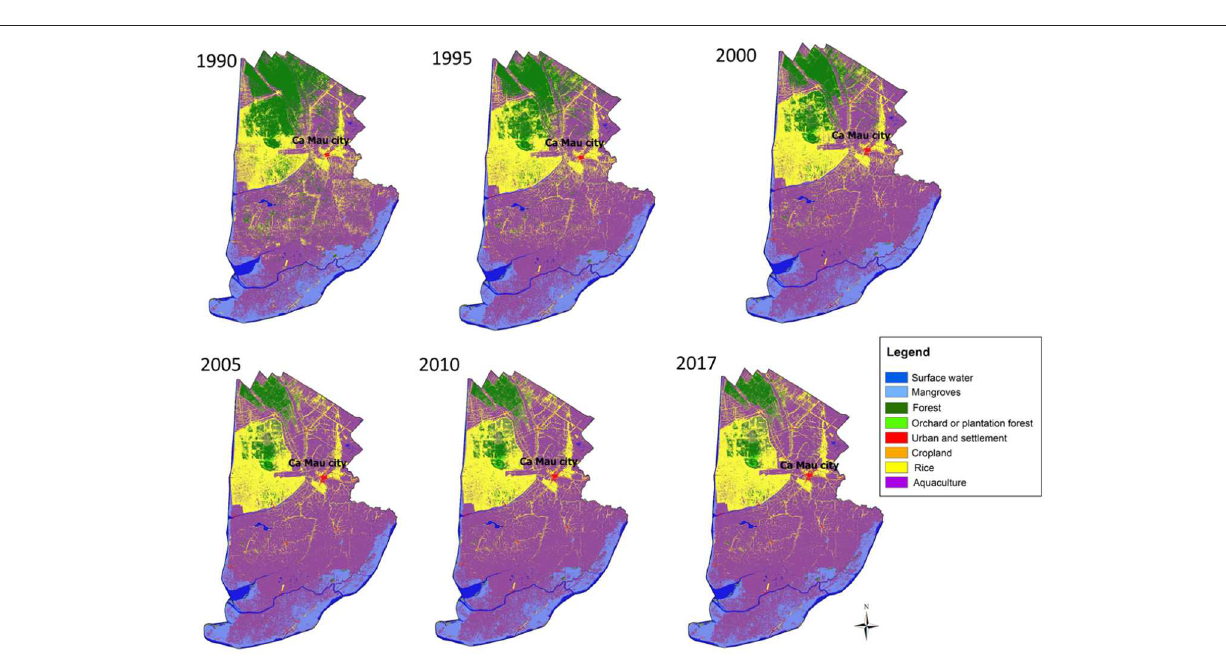
FIGURE 8 | Land cover change in Ca Mau with 5 year intervals from 1990 to 2017. The statistics can be found in Supplementary Table 2